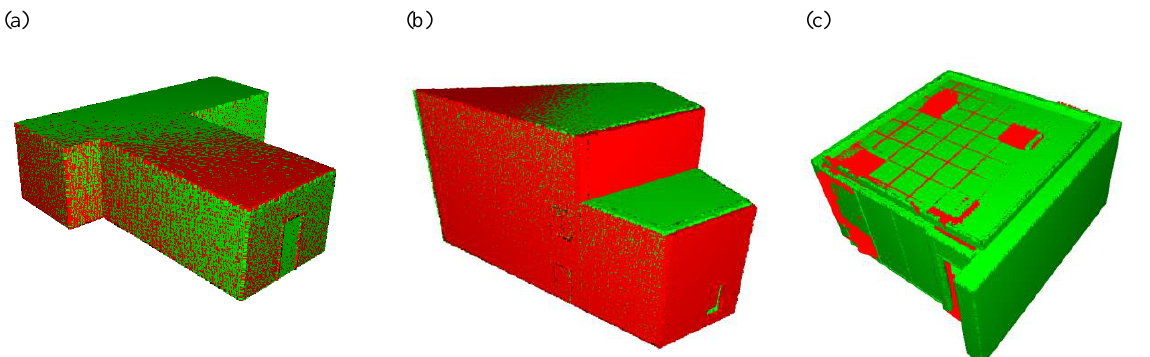
Figure 6 . Visualization of registered models from (a) dataset 1 (b) dataset 2, and (c) dataset